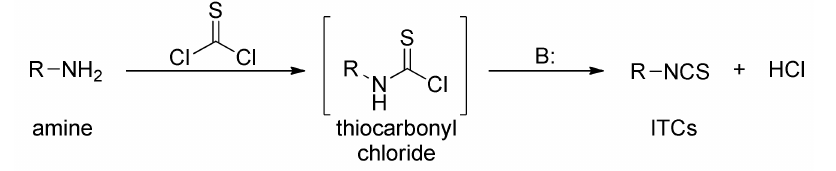
Figure 9. Synthesis of ITCs with thiophosgene.